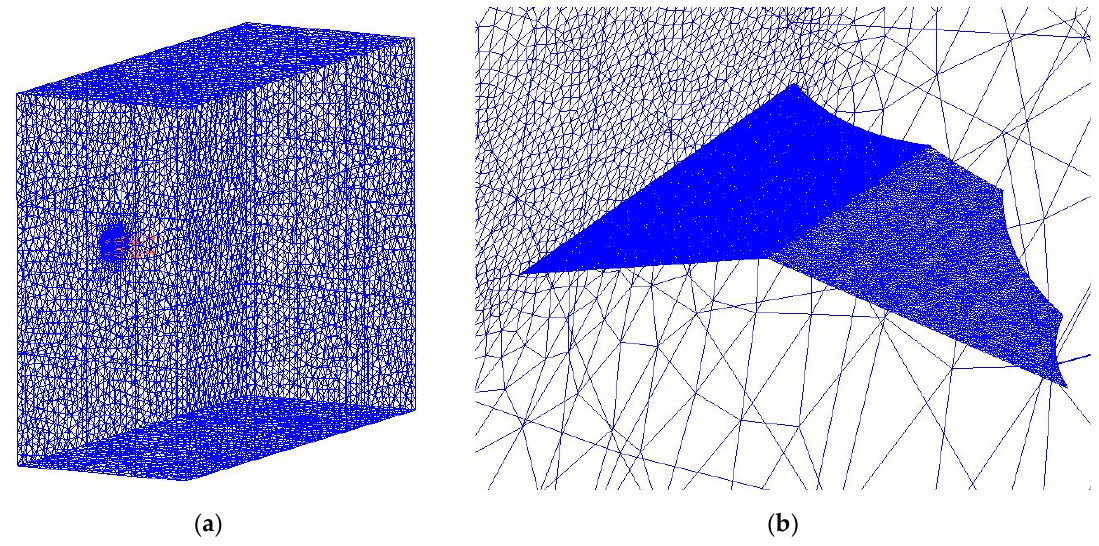
Figure 4. Computational grid disposition: ( a ) far field; ( b ) near wall.